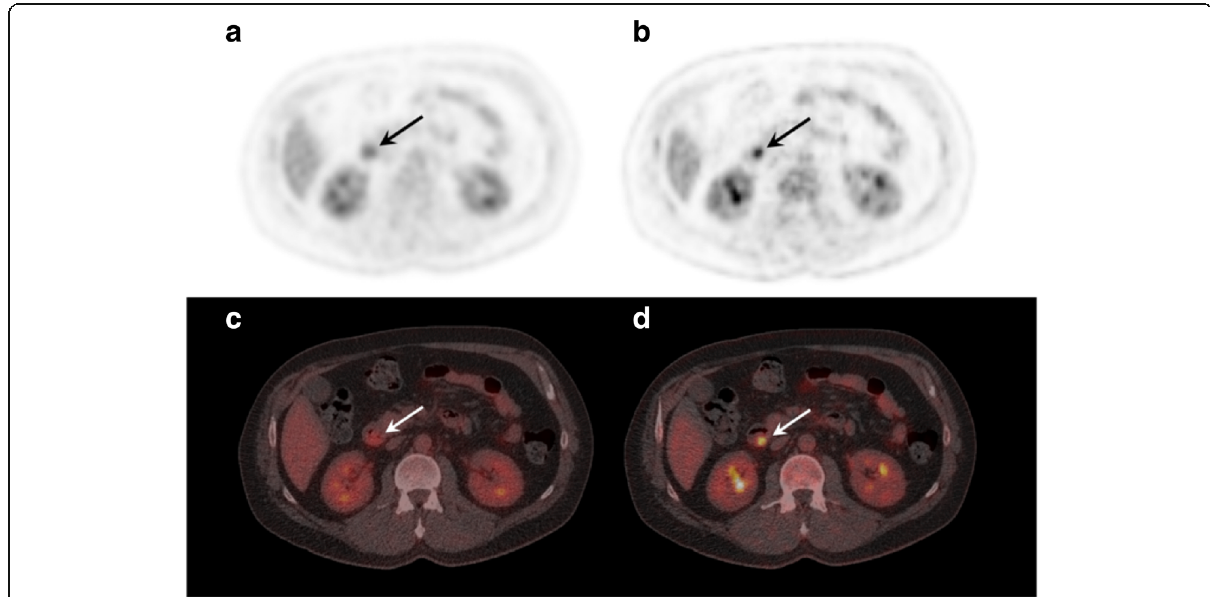
Fig. 1 Optimal respiratory gating improves detection of small pancreatic and ampullary lesions. A [ 18 F]FDG PET/CT scan reconstructed according to EANM guidelines ( a , c ) and with optimal respiratory gating ( b , d ), demonstrating markedly improvement of a small ampullary lesion in a 45-